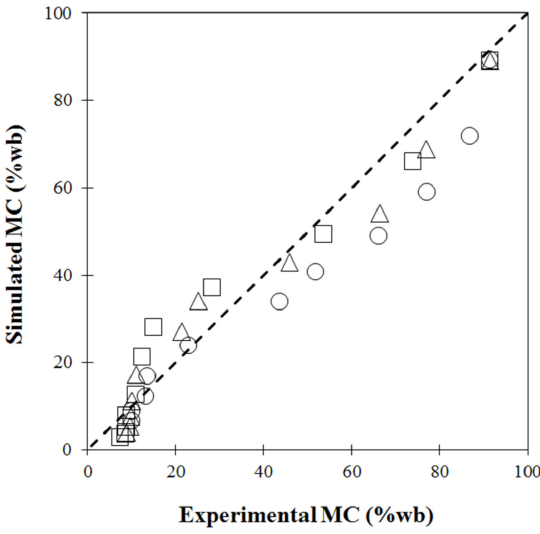
Figure 2. Validation plot of moisture content (%wb): circle (60 ◦ C), triangle (70 ◦ C) and square (80 ◦